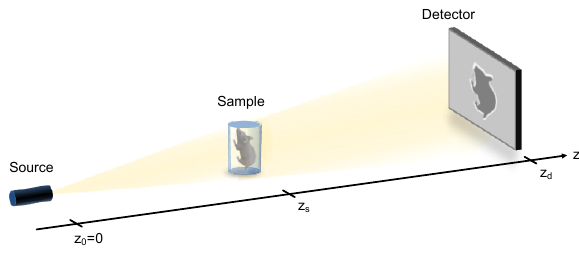
Figure 2. Propagation-based imaging